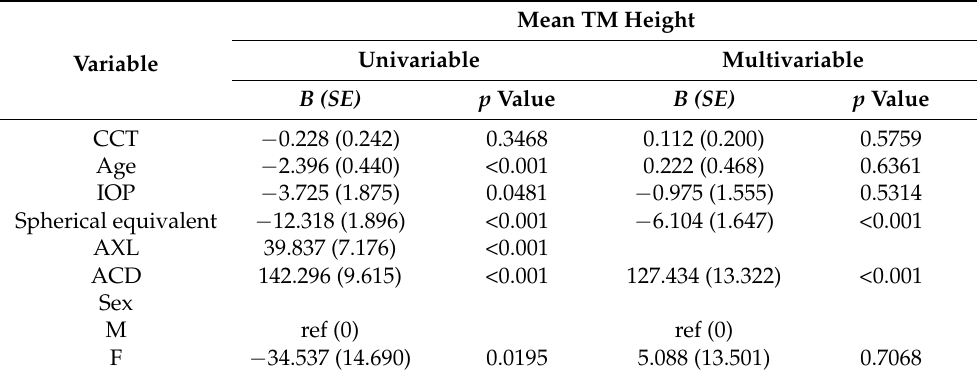
Table 3. Linear regression analysis of the factors affecting trabecular meshwork (TM)